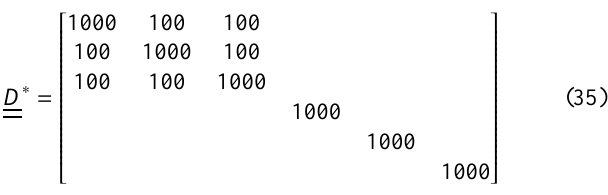
Figure 8. Components of the wryness vector: κ ∗ (dashed line), κ ∗ (dash-dotted line). Case 1a ( (cid:13) ), 1b ( 4 ), 1c ( 5 ), 3 1d ( ∗